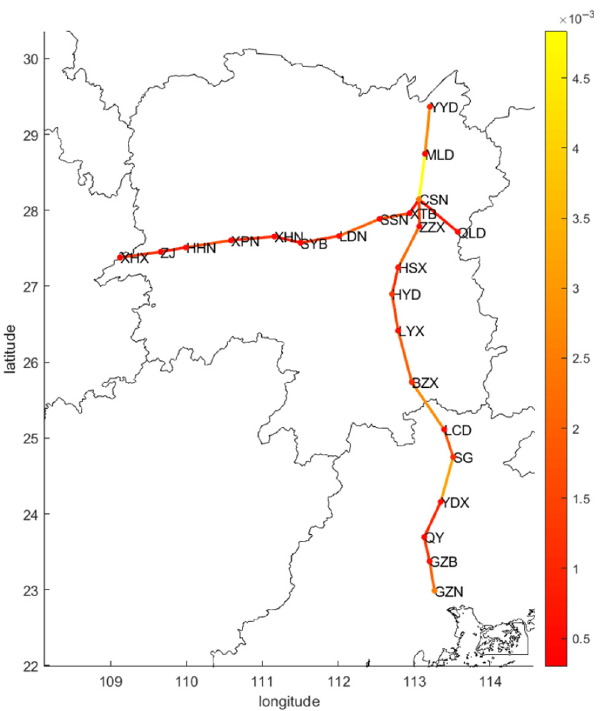
Figure 2. Failure probability of sections and